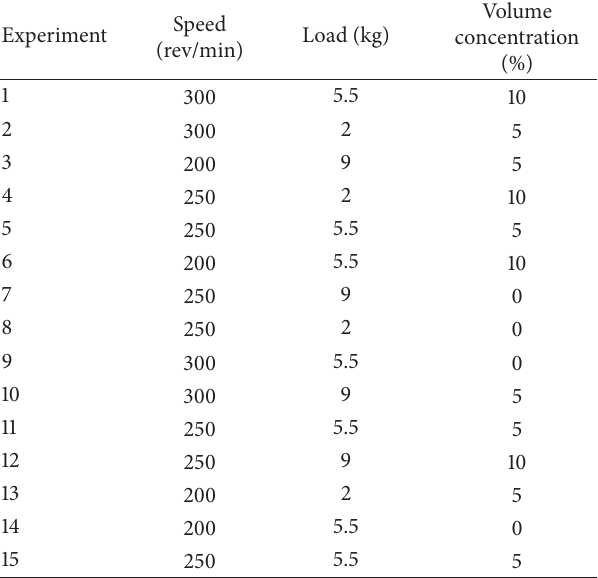
Table 3: Design values obtained from a